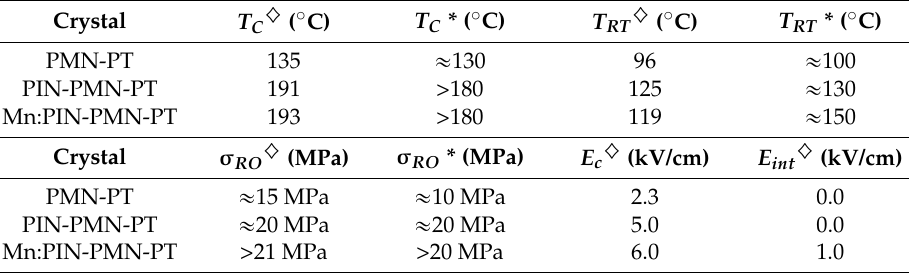
Table 5. Basic comparison between three generations of